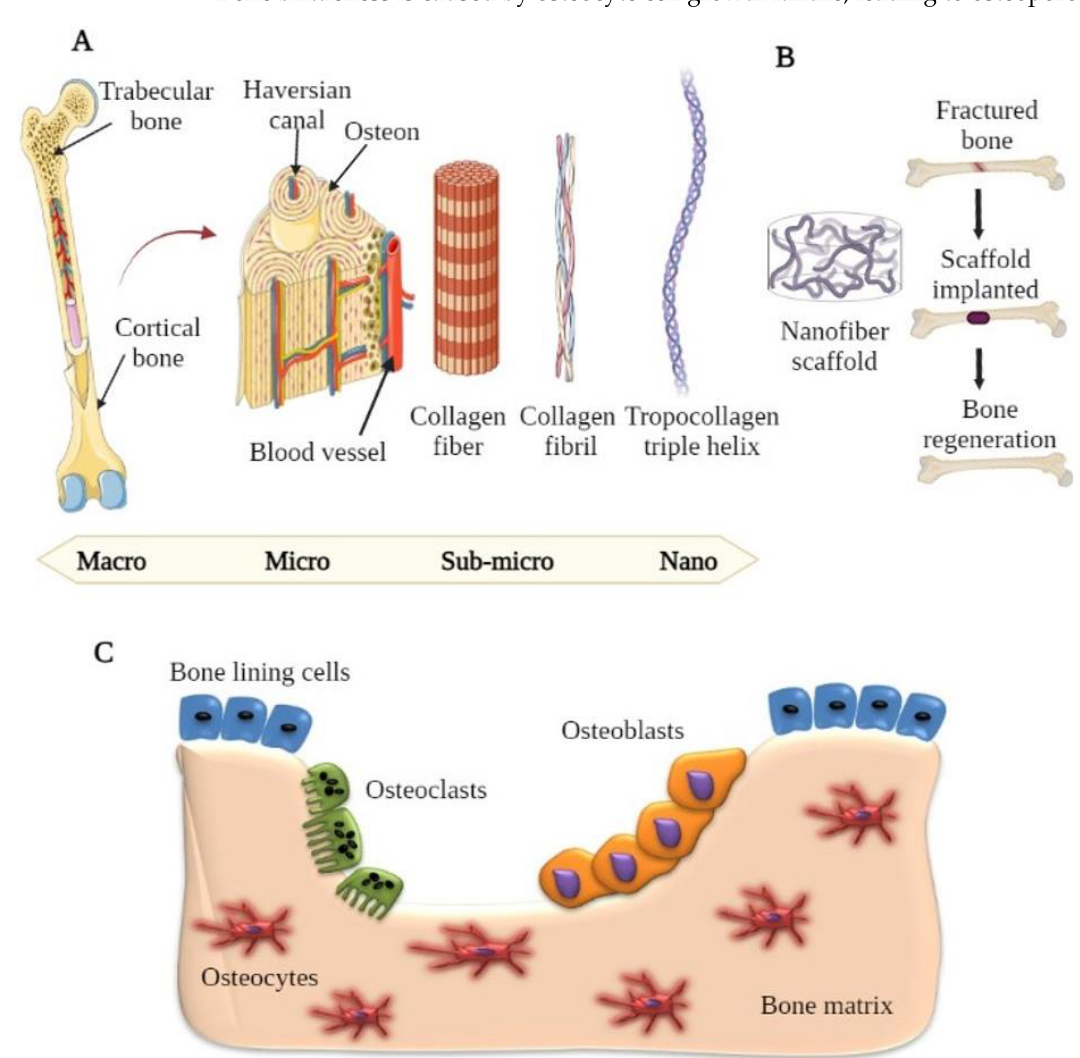
Figure 3. ( A ) Hierarchical structure of natural bone tissue from macro to nano scale. ( B ) Cumulative illustration of bone tissue engineering using nanofiber scaffold. ( C ) Representation of different types of bone cells required for bone regeneration.